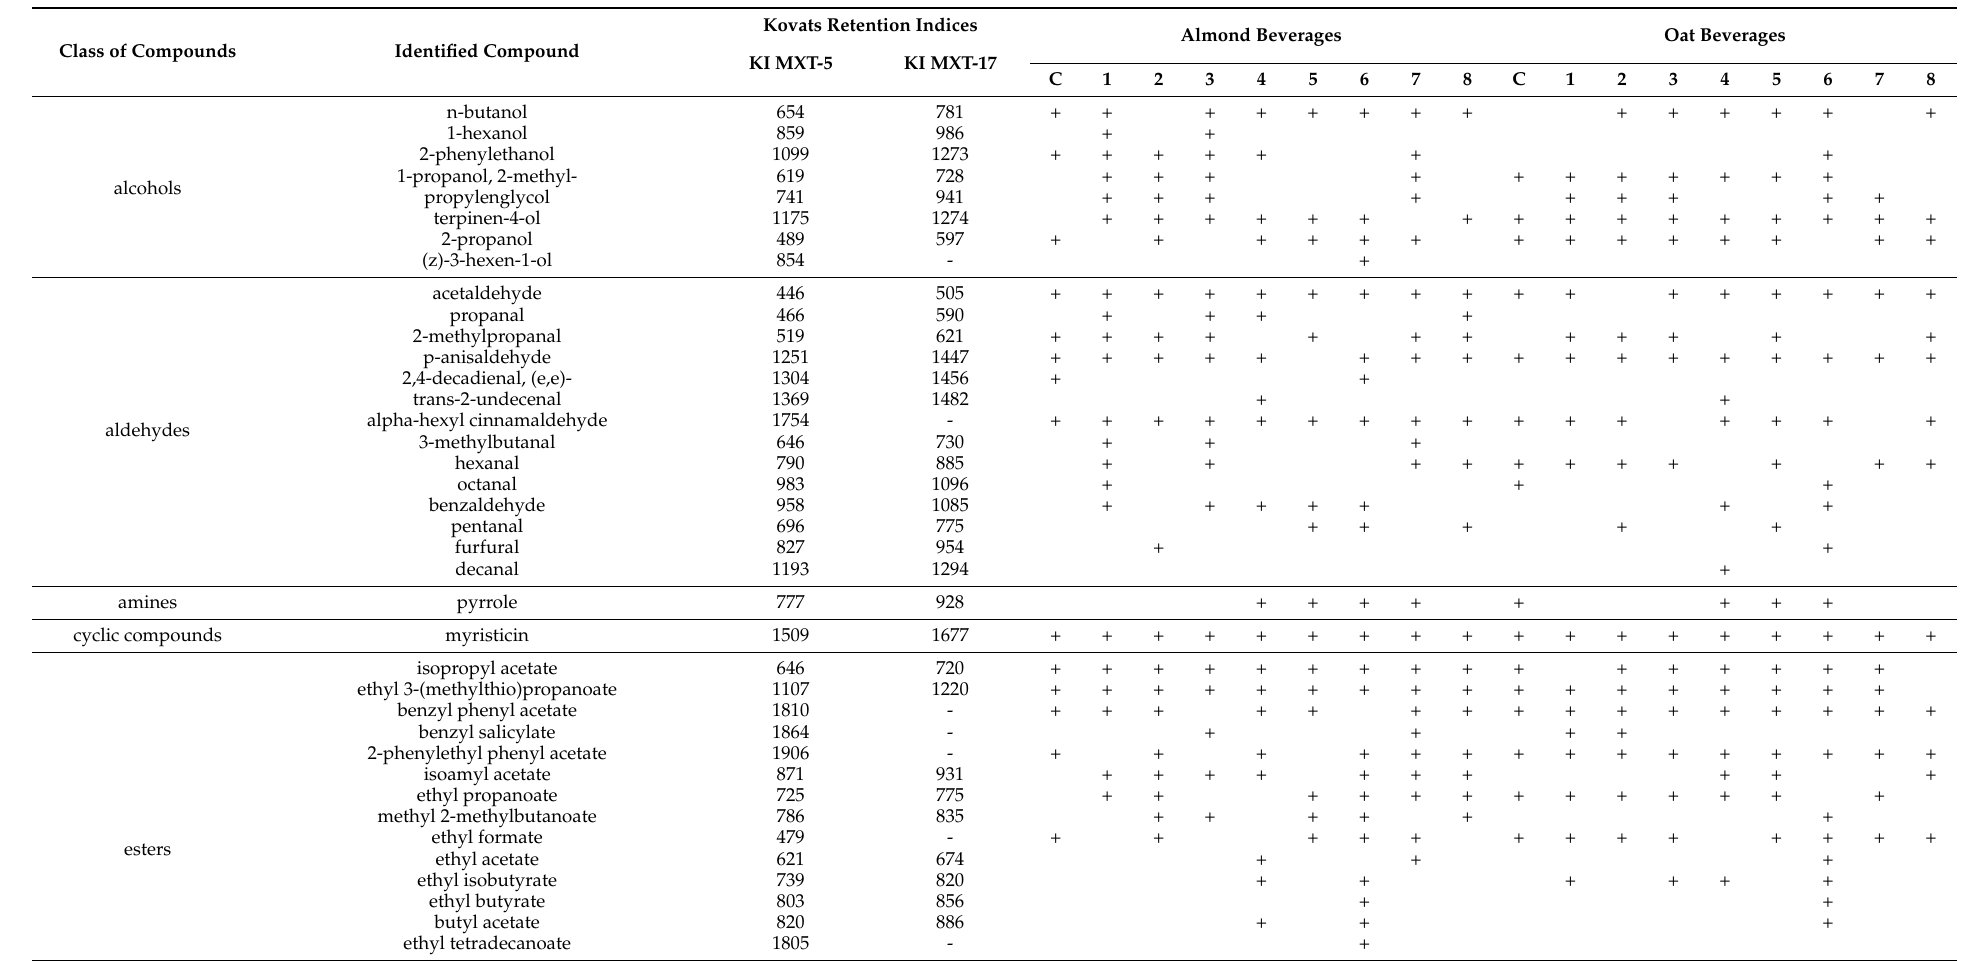
Table 5. Volatile compounds of the control and fermented PB